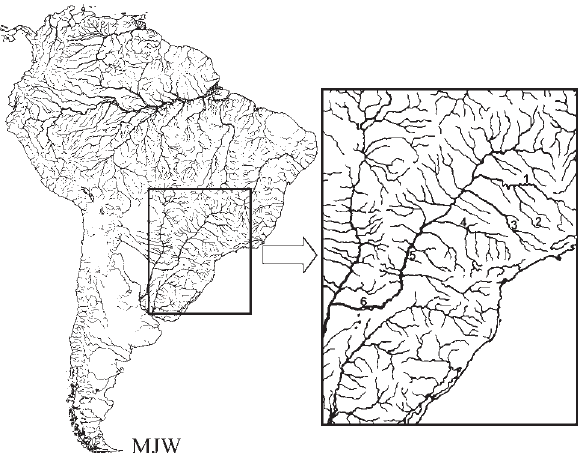
Figure 1 - South America geographic map indicating sampling localities of Leporinus elongatus from the Paraná River basin. (1) Grande River, (2) Mogi-Guaçu River, (3) Piracicaba/Tietê Rivers, (4) Paranapanema River, (5) Paraná River, Municipality of Guaíra, and (6) Paraná River, Munici- pality of Ayolas. (1-5) Brazil, (6)